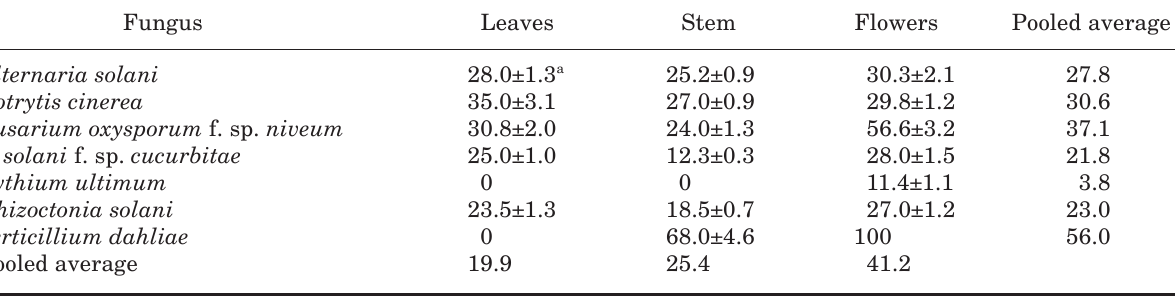
Table 5. Inhibition (%) of fungal growth with different parts of Hibiscus rosa-sinensis cv. white